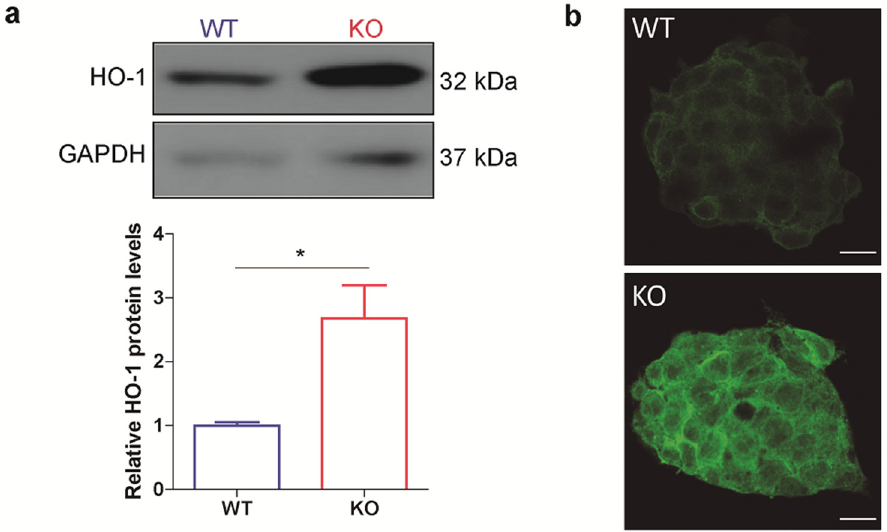
Figure 1. HO-1 protein levels are boosted in p53 knockout ES cells. WT and p53 KO ES cells were cultured under standard conditions. ( a ) HO-1 protein levels were analyzed by Western blot, upper panels show representative blots. GAPDH was used as the loading control. Lower panels show HO-1/GAPDH band densitometry relative to WT ES cells. Bars represent the mean ± SEM of three independent experiments. Asterisks indicate significant differences between cell lines (*, p < 0.05). ( b ) HO-1 levels were analyzed by Immunofluorescence. Representative confocal images of ES cell colonies are shown. The green pseudocolor represents HO-1 specific immunostaining, scale bars: 10 μ m.